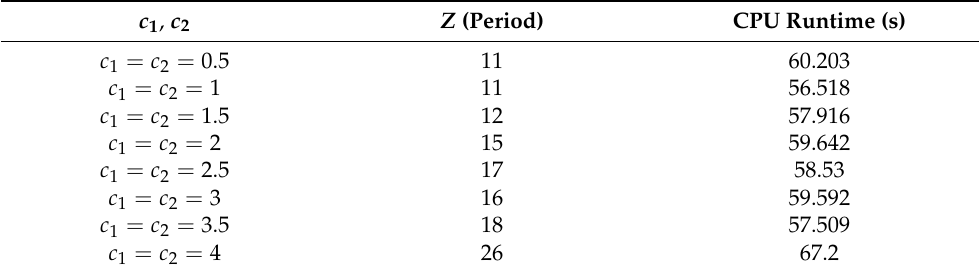
Table 7. CPU runtime and objective value of instance10 with different c 1 , c 2